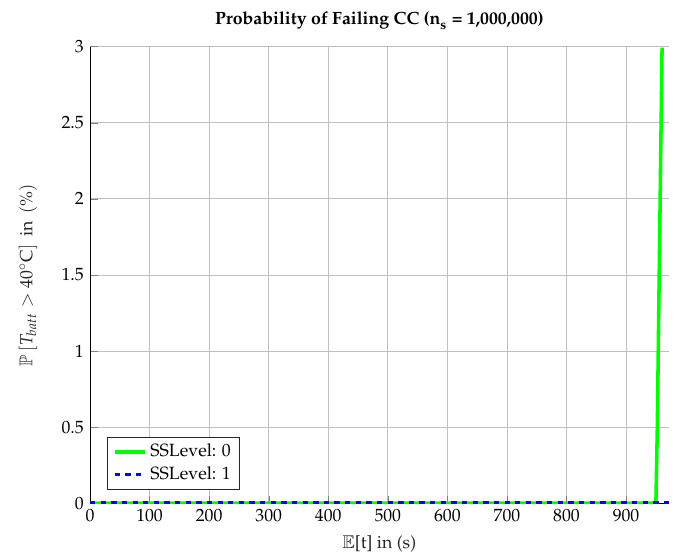
Figure 4. Probability of fulfilling the chance constraint over time for charging.